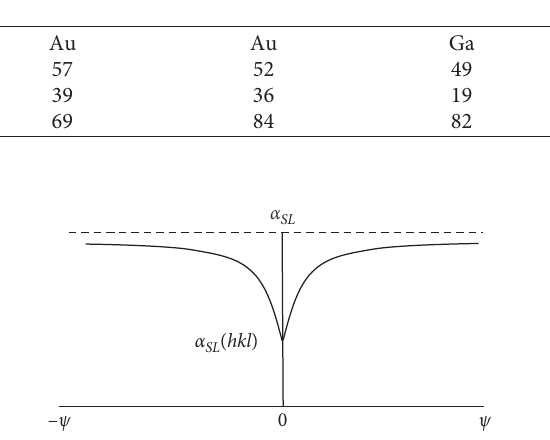
Figure 3: Anisotropy of crystal’s free surface energy nearby the singular faces with small crystallographic indexes { hkl